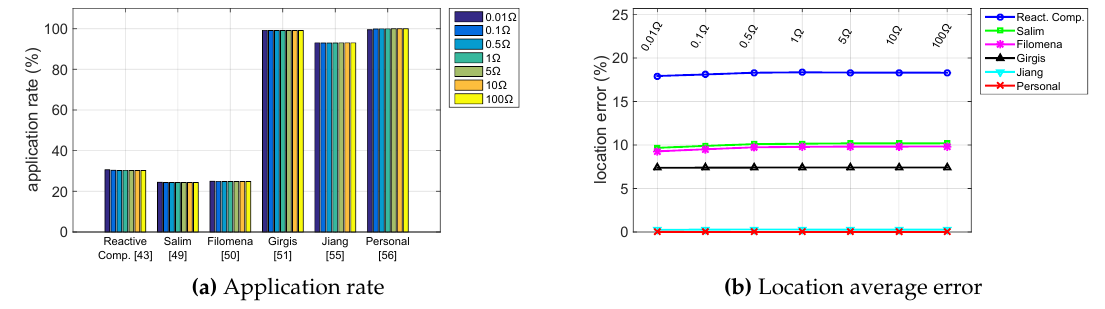
Figure 17. Sheath-to-ground resistance